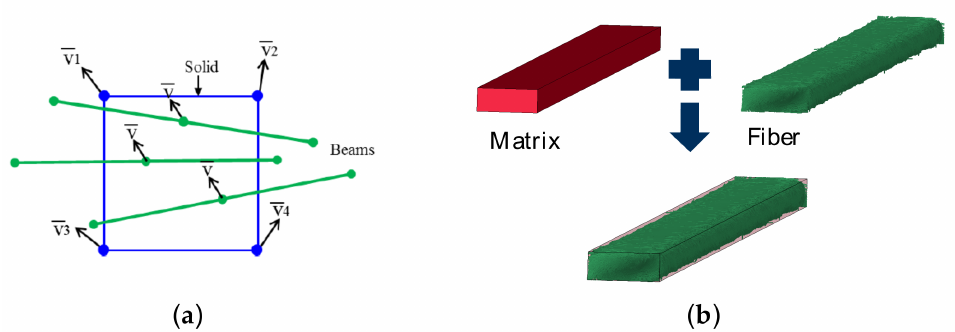
Figure 8. Applied approach for Fiber-Matrix-Coupling ( a ) Domain Superposition Technique [42] ( b ) Coupled composite